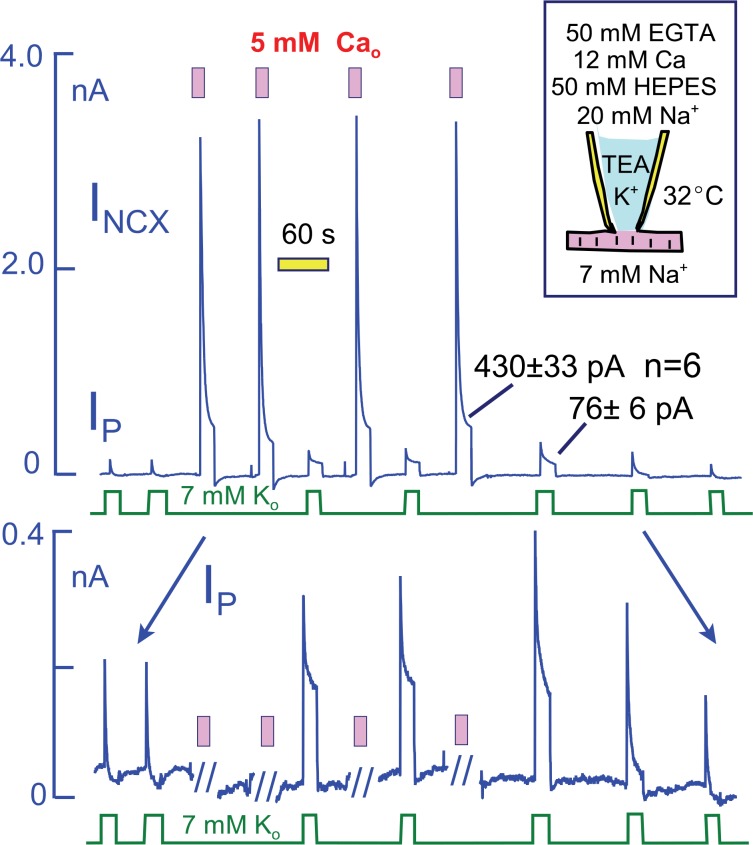
Na/K pump and Na/Ca exchange currents in myocytes that overexpress NCX1 Na/Ca exchangers by more than five-fold.The cytoplasmic (pipette) solution is designed to highly buffer free Ca and protons. The magnitudes of exchange currents after 15 s are much greater than the 15 s pump currents. Thus, Na/K pumps and Na/Ca exchangers cannot be sharing a restricted subsarcolemmal space. Top panel. Complete current record in which Na/K pump currents and Na/Ca exchange curerrents were activated alternately. Bottom panel. Expanded view of the current record to accurately depict the Na/K pump current. Pump currents decay completely before activation of Na/Ca exchange. In response to Na/Ca exchange currents, peak pump currents double and a maintained current develops. These changes reverse completely over 3 min after the last Ca elevation.